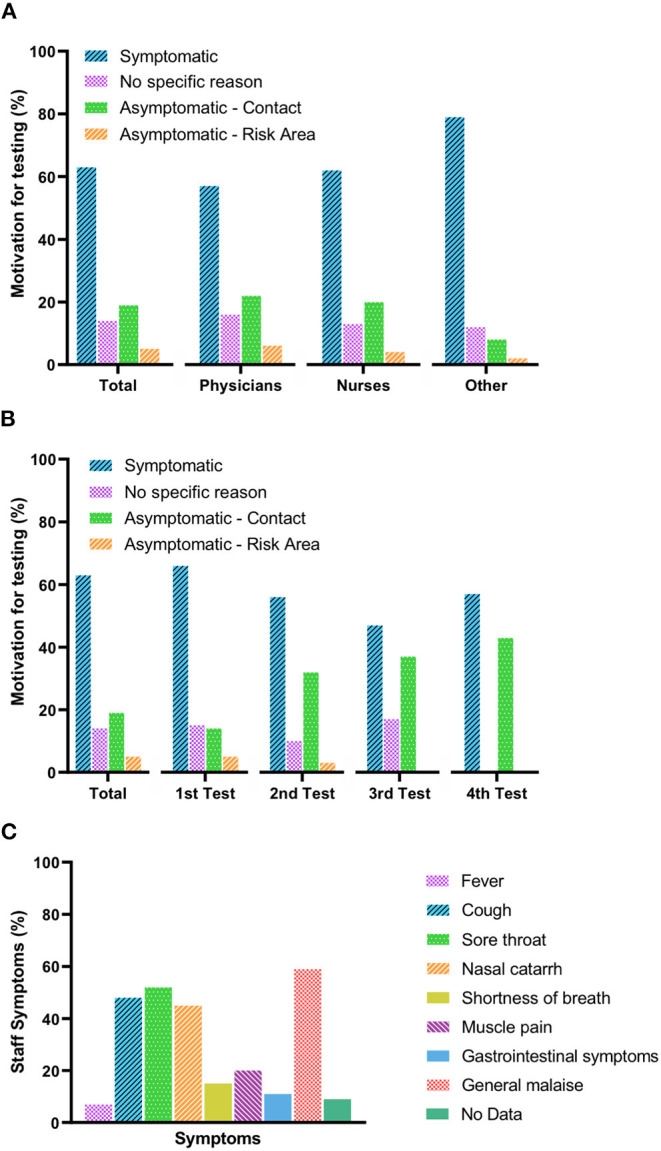
Motivation for SARS-CoV-2 testing and symptoms reported by healthcare workers. (A) Motivations (percentage) for SARS-CoV-2 testing per professional group. (B) Motivations (percentage) for SARS-CoV-2 retesting in healthcare workers. (C) Symptoms reported by healthcare professionals. Fever is defined as body temperature over 38°C; cough includes dry and productive cough; nasal catarrh includes rhinitis and stuffed nose; muscle pain includes general and jaw muscle pain; gastrointestinal symptoms include diarrhea, nausea, and vomiting; and general malaise includes fatigue, headaches, chill, and general discomfort.